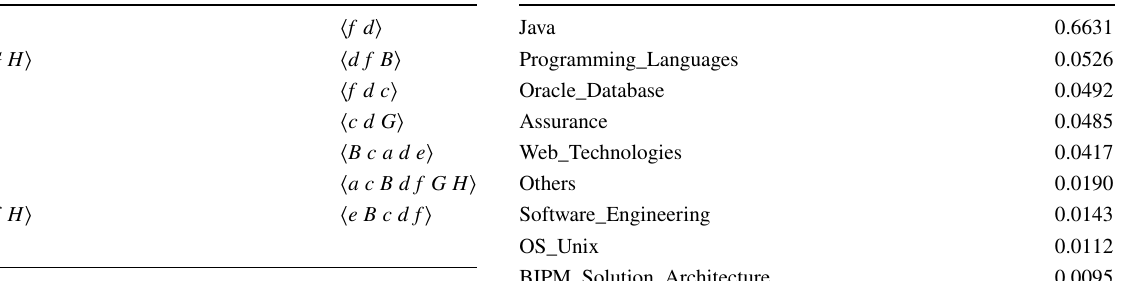
Table 4 Example sequences for 15 employees over M = 8 trainings Table 5 Top 10 outgoing edges from the node